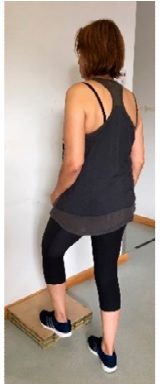
Figure 2. Step test example.